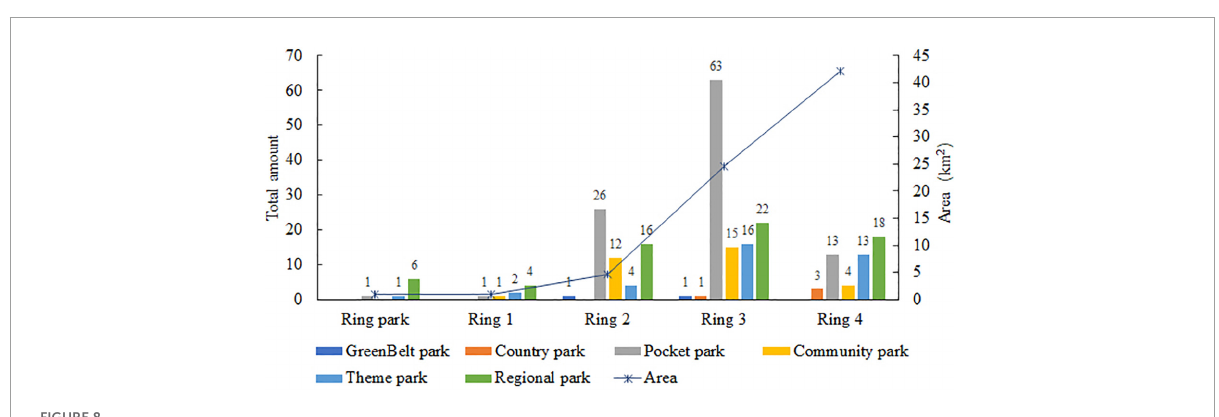
FIGURE8 Amount and area of various types of parks in different rings.